Question: Identify the chart type used in this figure.
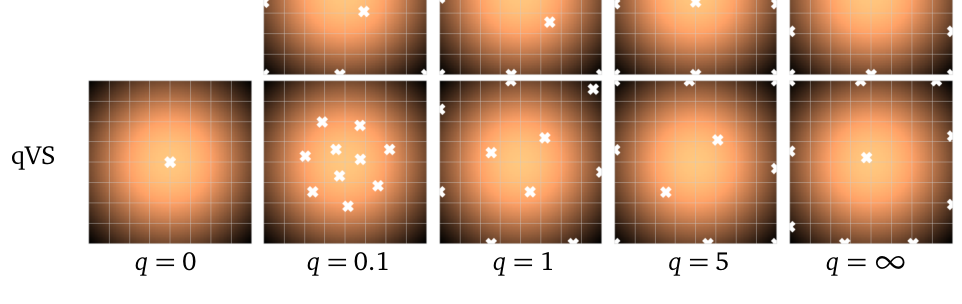
Answer: heatmap